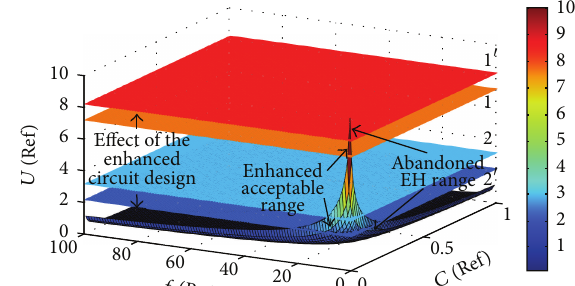
Figure 3: Function of enhanced circuit design.